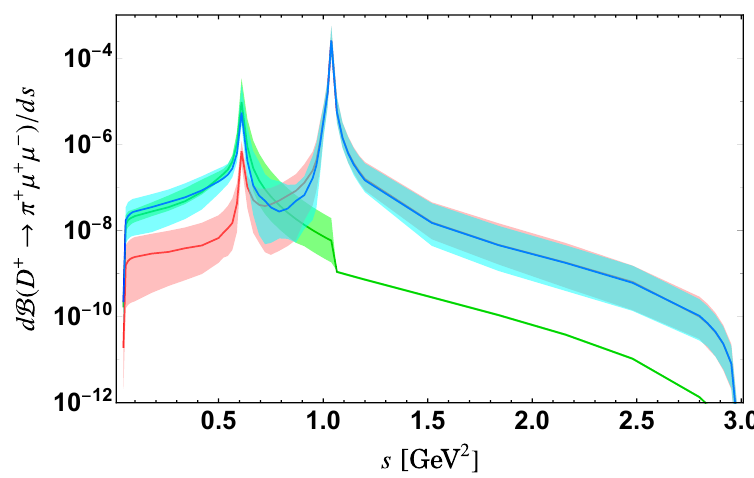
Figure 4 . Distribution of the B ( D + → π + µ + µ − ) in the SM. In blue the total branching ratio, in red the contribution from Y ( d ) , and in green that of C ( d ) per eq. (4.18). The error bands on the SM prediction, determined as explained in section 4.3, are